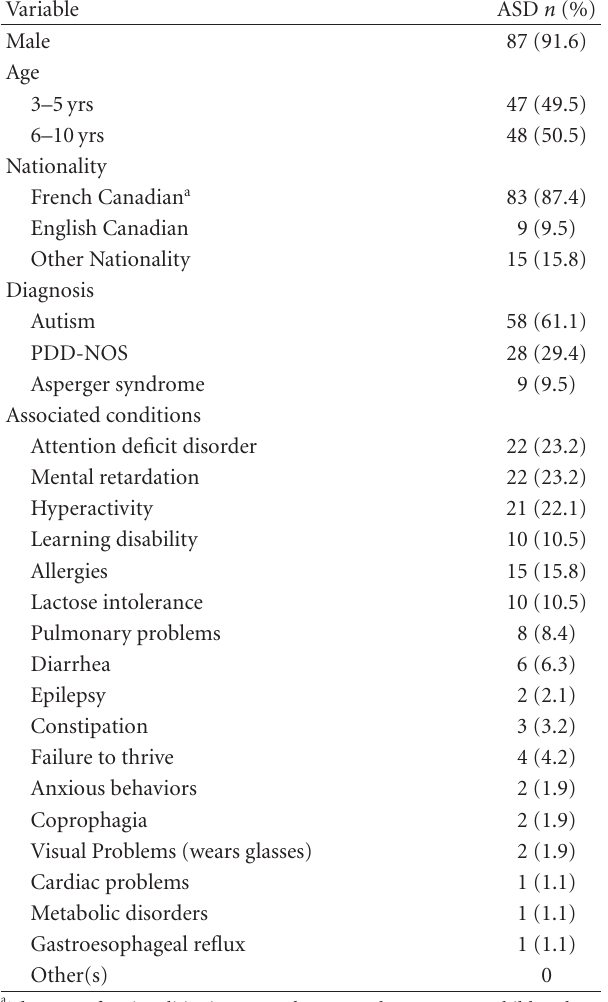
Table 1: Characteristics of the sample (children with ASD; n =